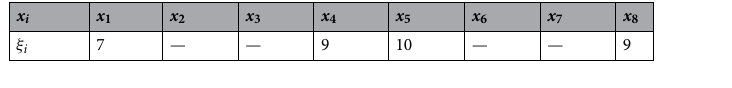
Table 1. ξ i is the pre estimate of x i profit, i = 1, 2, . . . , 8